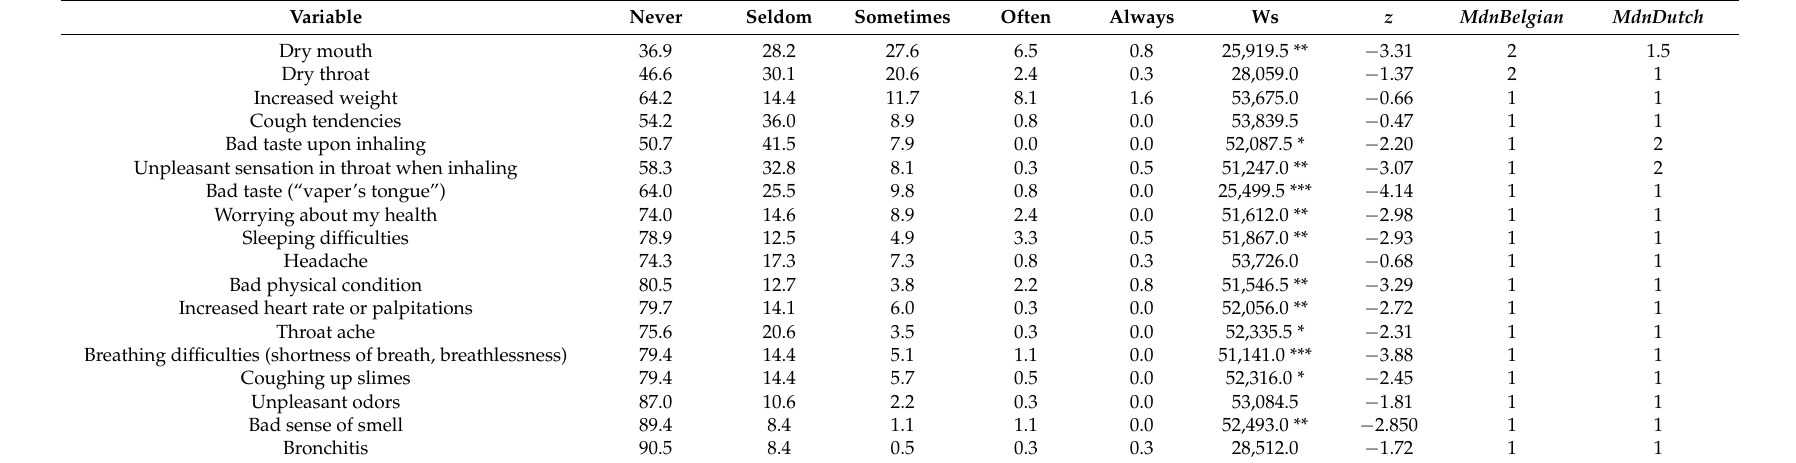
Table 6. Distributions of responses (in %) of current non-smoking vapers ( n = 369) for several experienced disadvantages due to vaping and differences between vapers of the Dutch Current vs. Belgian Current group with regard to these